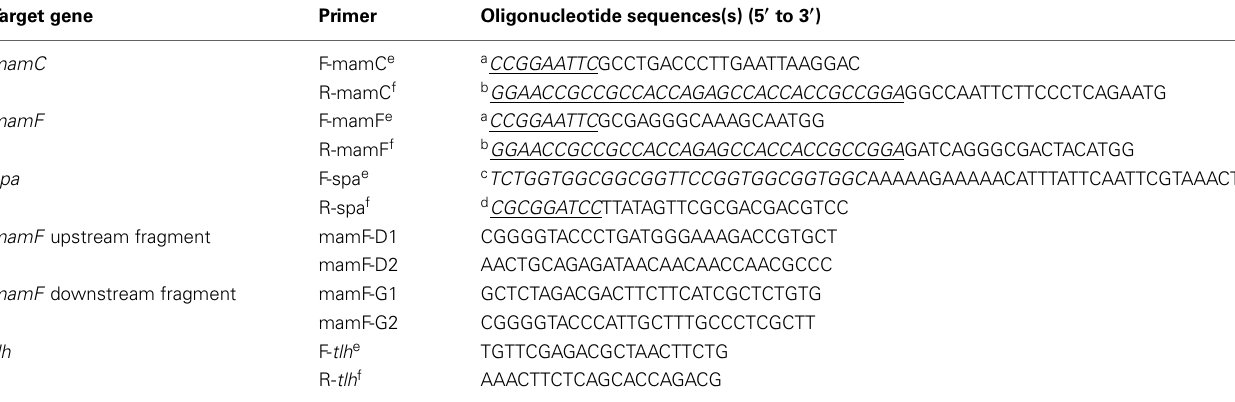
Table 2 | Primers used for PCR. Target